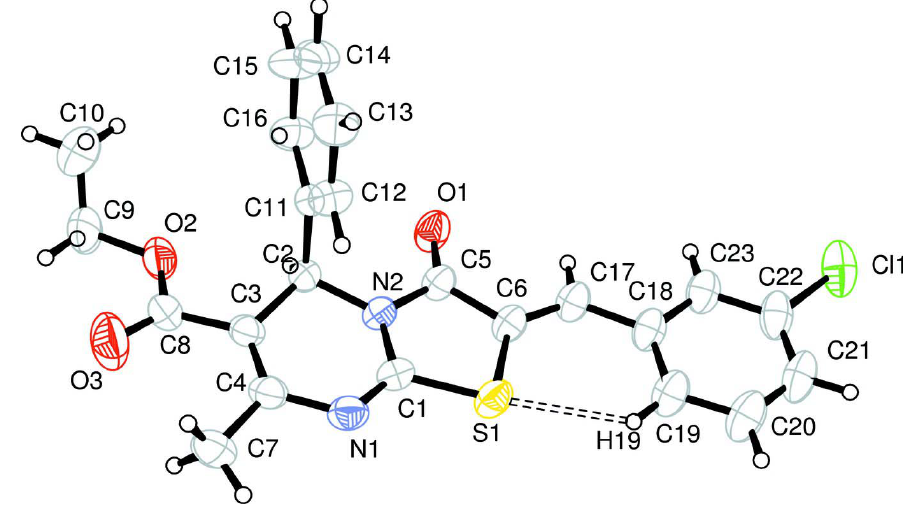
The molecular structure of I with the atom numbering scheme. Displacement ellipsoids are drawn at 50% probability level. H atoms are presented as a small spheres of arbitrary radius. The C—H···S intramolecular hydrogen bond is indicated by dashed